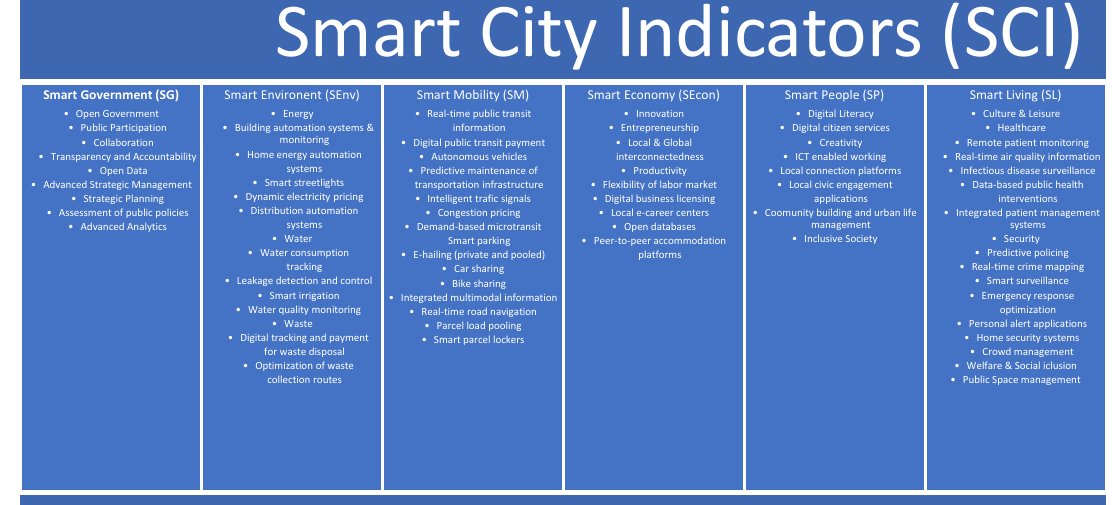
Figure 4. Smart city indicators with revised evaluation criteria for the study.